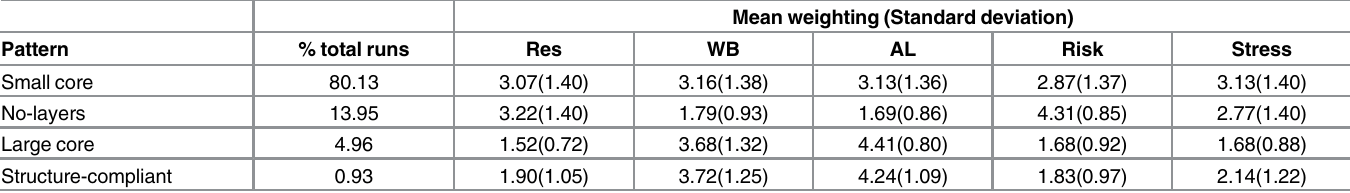
Table 2. Mean fitness weightings for each social structure pattern in the first experiment with an initial equal distribution of agent strategies.